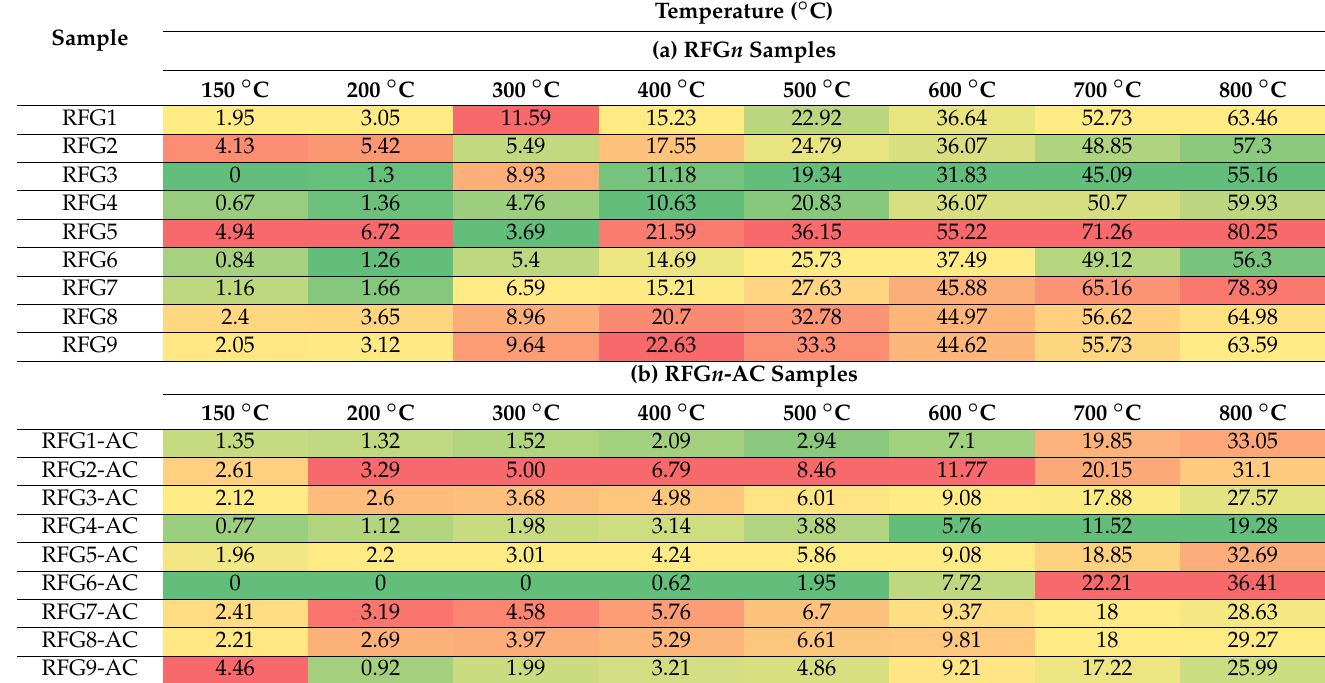
Table 6. TGA thermal decomposition (% weight losses) of RFG n and RFG n -AC samples